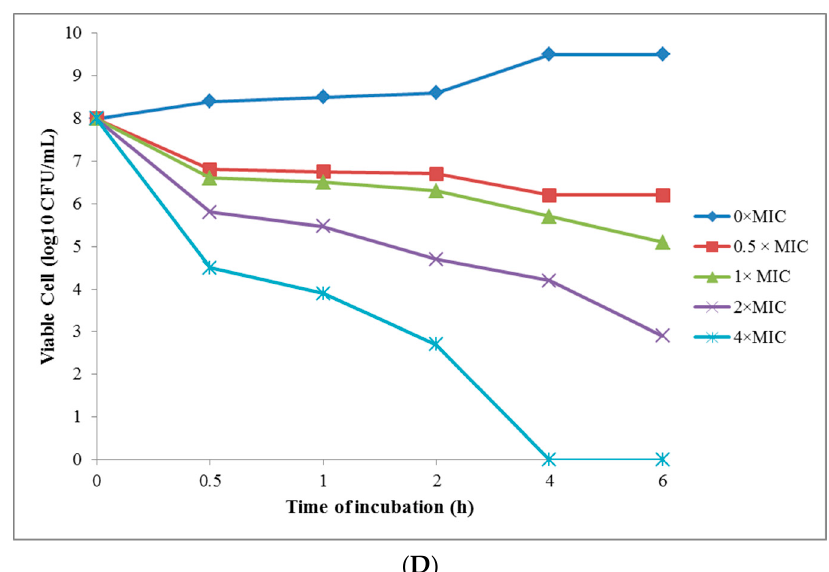
Figure 6. ( A ) The time-kill curve plots for Escherichia coli ( B ) Shigella flexneri ( C ) Bacillus cereus , and ( D ) Staphylococcus aureus , following the exposure to the greenly synthesized AgNPs at 0 × MIC, 0.5 × MIC, 1 × MIC, 2 × MIC, and 4 × MIC.